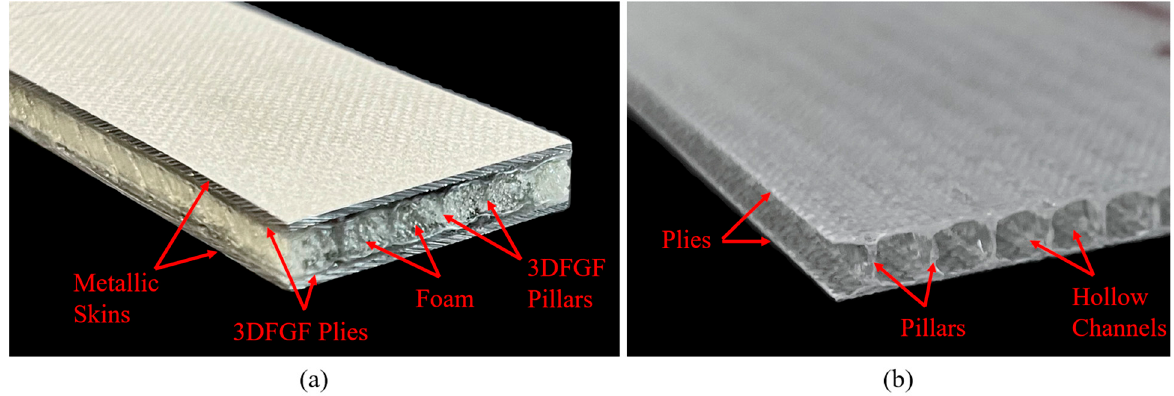
Figure 1. ( a ) 3DFML and ( b ) 3DFGF layouts.